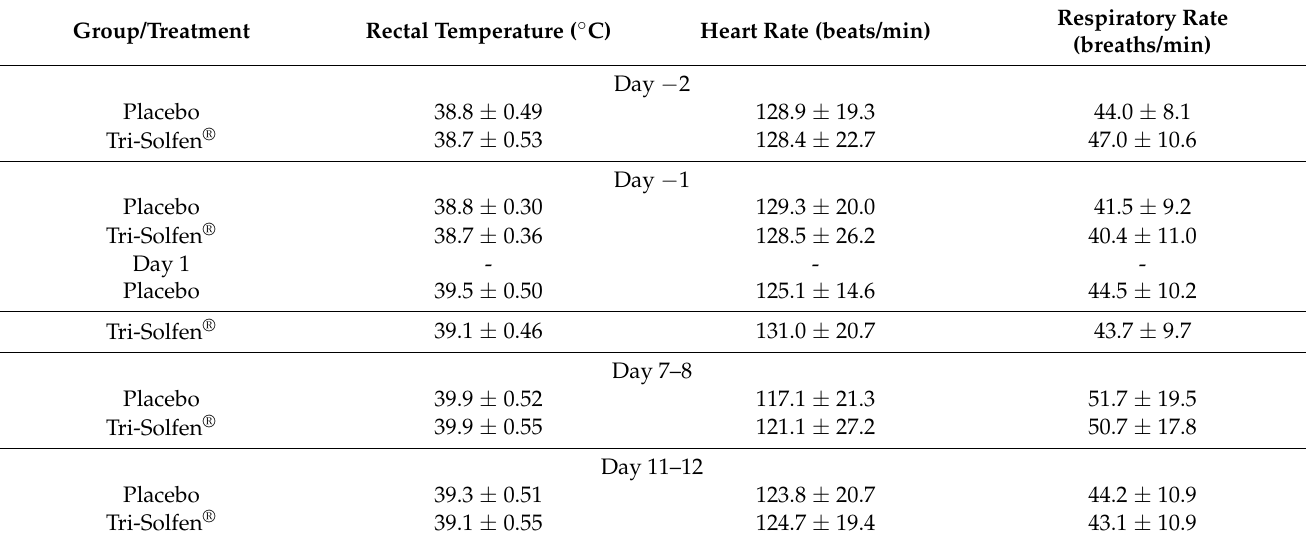
Table 4. Mean clinical data (rectal temperature, heart rate, respiratory rate) for Placebo and Tri-Solfen ® -treated calves over time in Study 2.